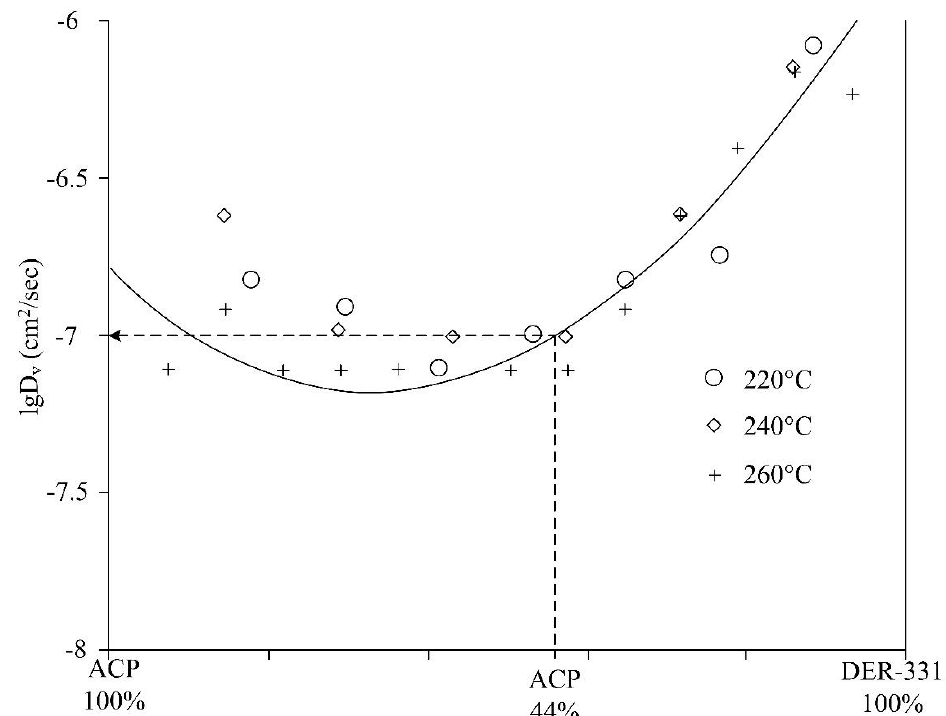
Figure 5. Concentration dependences of the interdiffusion coefficient on semi logarithmic scale at 220, 240, and 260 °С.